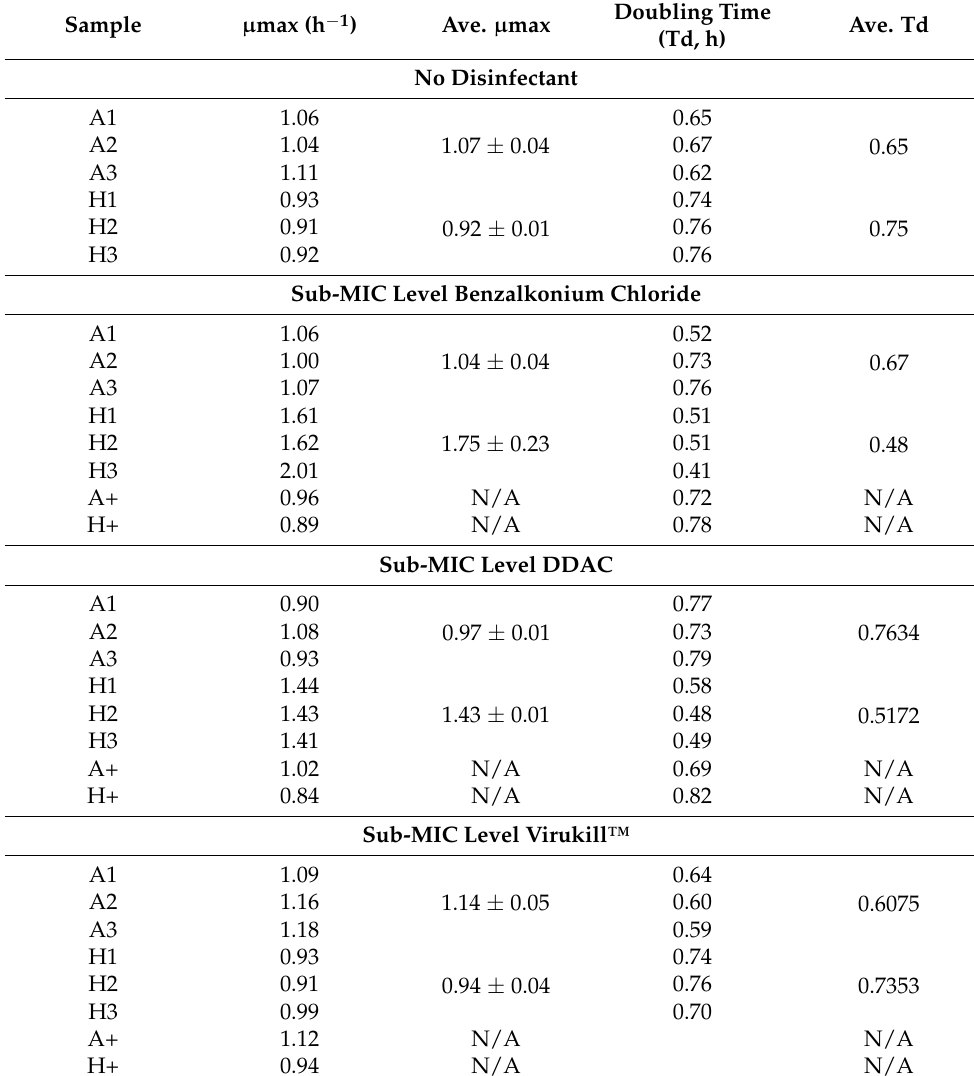
Table 1. Calculated maximum specific growth rate ( µ max h − 1 ) and growth kinetics analysis of S. marcescens ATCC 13880 and Serratia sp. HRI without and after adding three disinfectants (Benzalko- nium chloride, DDAC, and Virukill TM ). A1-3: S. marcescens ATCC 13880 biological replicates exposed at 0.0001% of disinfectant; H1-3: Serratia sp. HRI biological replicates exposed at 0.01% of